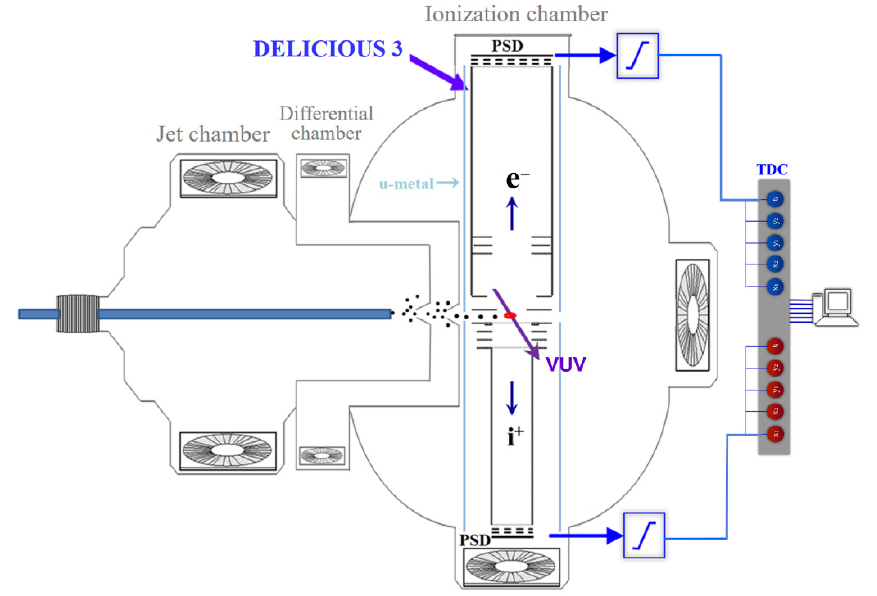
Figure 1. A schematic diagram of the experimental setup, including the i 2 PEPICO spectrometer and the jet, differential, and ionization chambers.